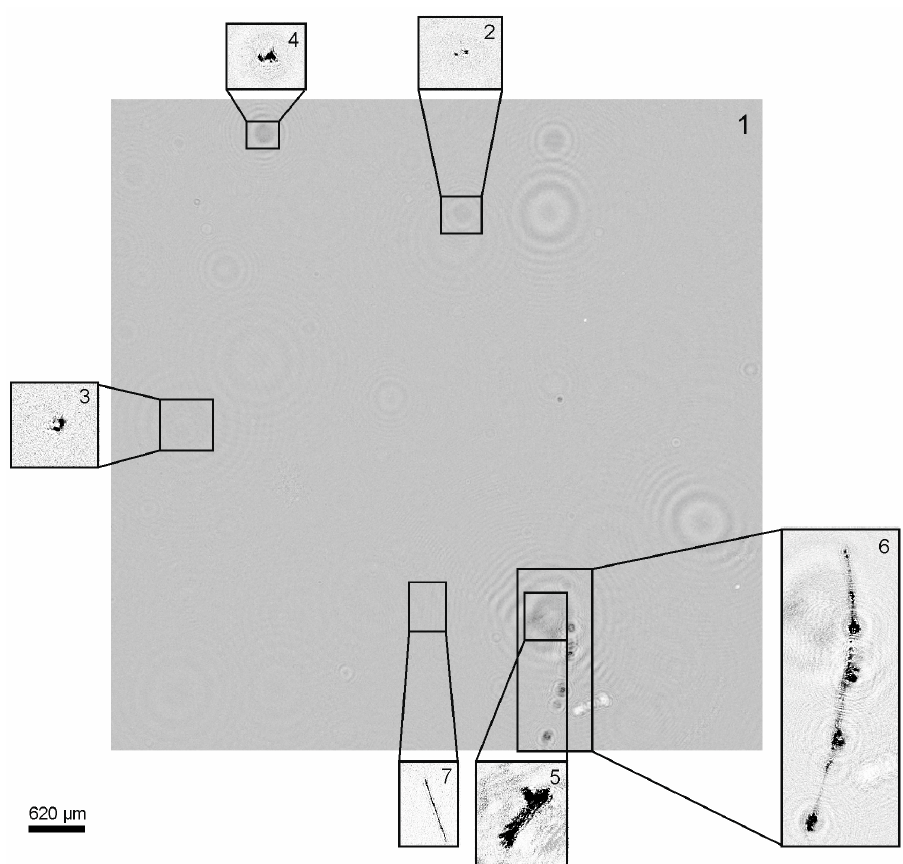
Figure 9. 1—Digital hologram recorded at a depth of 388 m after removal of the background noise; 2, 3—reconstructed images of particles classified as ‘Other’; 4, 5, 6—reconstructed images of particles classified as ‘Marine snow’; 7—reconstructed image of a particle classified as ‘Phytoplankton chain’. The specified scale refers to reconstructed images.